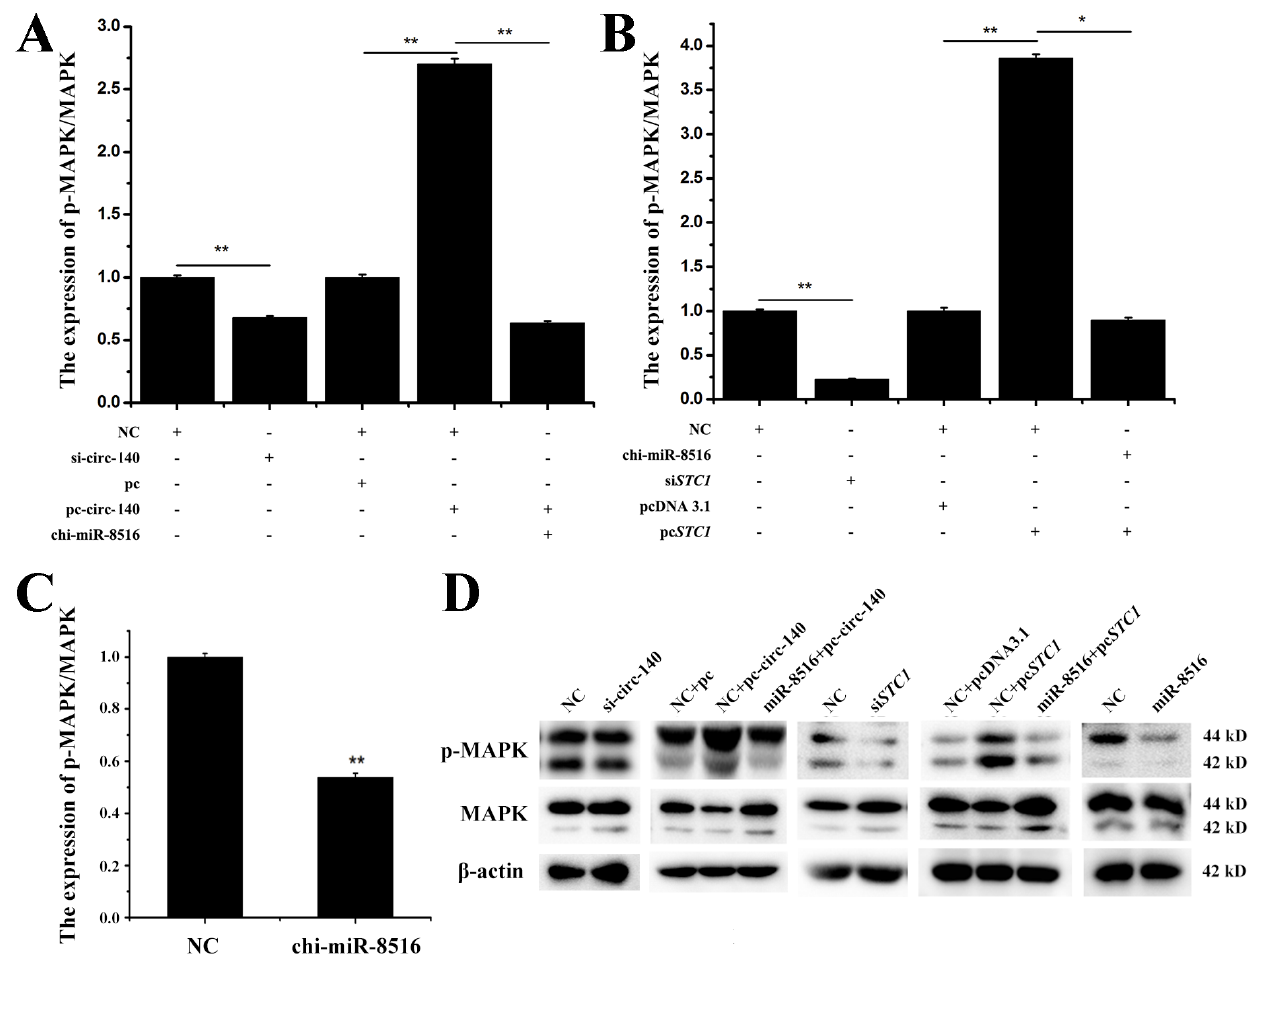
Figure 4. Effects of circ-140/chi-miR-8516/ STC1 on MAPK phosphorylation. ( A – C ) The regulation of MAPK phosphoryla- tion by circ-140, STC1 and chi-miR-8516, respectively; ( D ) immunoblots of total and phosphorylated MAPK proteins, and β -actin proteins. * p < 0.05; ** p <